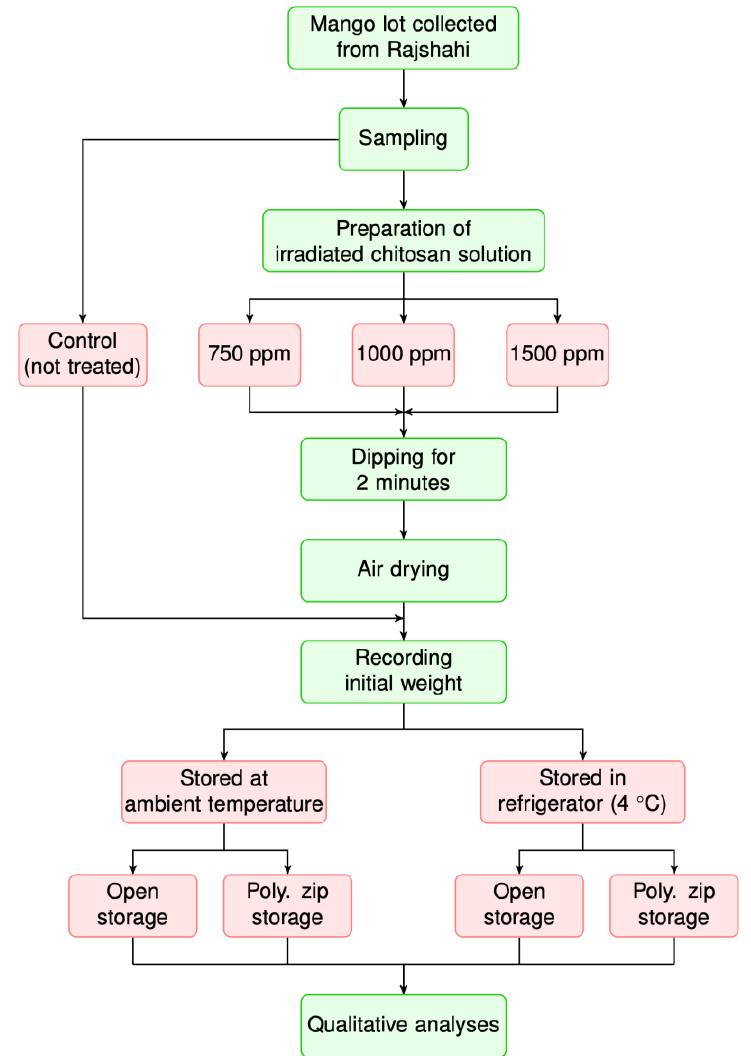
Figure 1. Schematic flow of the experimental procedure. The red-filled boxes denote the experimental factors.